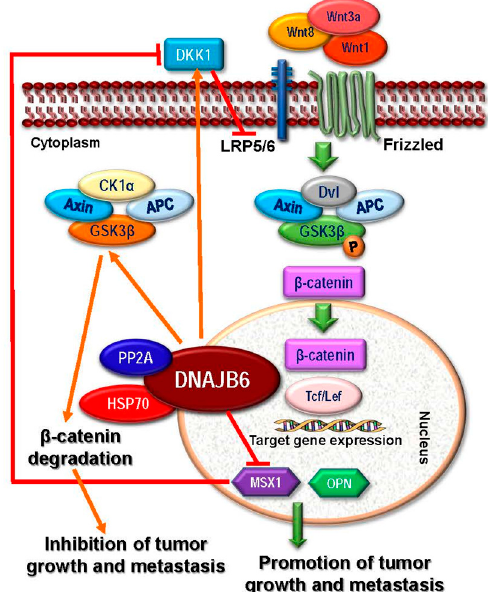
Figure 3. The HSP40 family member, DNAJB6a (MRJ), prevents tumor formation through inhibition of the Wnt pathway. Upon Wnt protein ligands like Wnt8, Wnt1 and Wnt3a binding to the cell surface receptor complex of Frizzled and LRP5/6, cytoplasmic β -catenin is stabilized followed by nuclear translocation. In the nucleus, β -catenin binds its cofactor TCF/LEF (T-cell factor/lymphocyte enhancer factor) leading to transcription of specific target genes such as osteopontin and muscle segment homebox 1 (MSX1) ultimately promoting cancer growth and metastasis, through induction of epithelial mesenchymal transition (EMT). DNAJB6a reverses the EMT and inhibits this pathway by activating GSK3 β . DNAJB6 is chaperone for a multiprotein complex containing another chaperone HSP70 and PP2A, a phosphatase that activates glycogen synthase kinase 3 β (GSK3 β ) by dephosphorylation. Active GSK3 β in turn promotes β -catenin proteosomal degradation forming a complex with adenomatous polyposis coli (APC) gene product, casein kinase 1 α (CK1 α ) and a scaffolding protein Axin, ultimately inhibiting the tumor growth and metastasis. DNAJB6 mediated β -catenin degradation is therefore also responsible for downregulation of β -catenin-dependent transcription of MSX1, which in turn is a repressor of dickkopf 1 homologue (DKK1) transcription, a secreted Wnt signaling inhibitor. Thus, reduced MSX1 expression upregulates DKK1 expression establishing a feed-forward repression loop to check on Wnt/ β -catenin signaling.